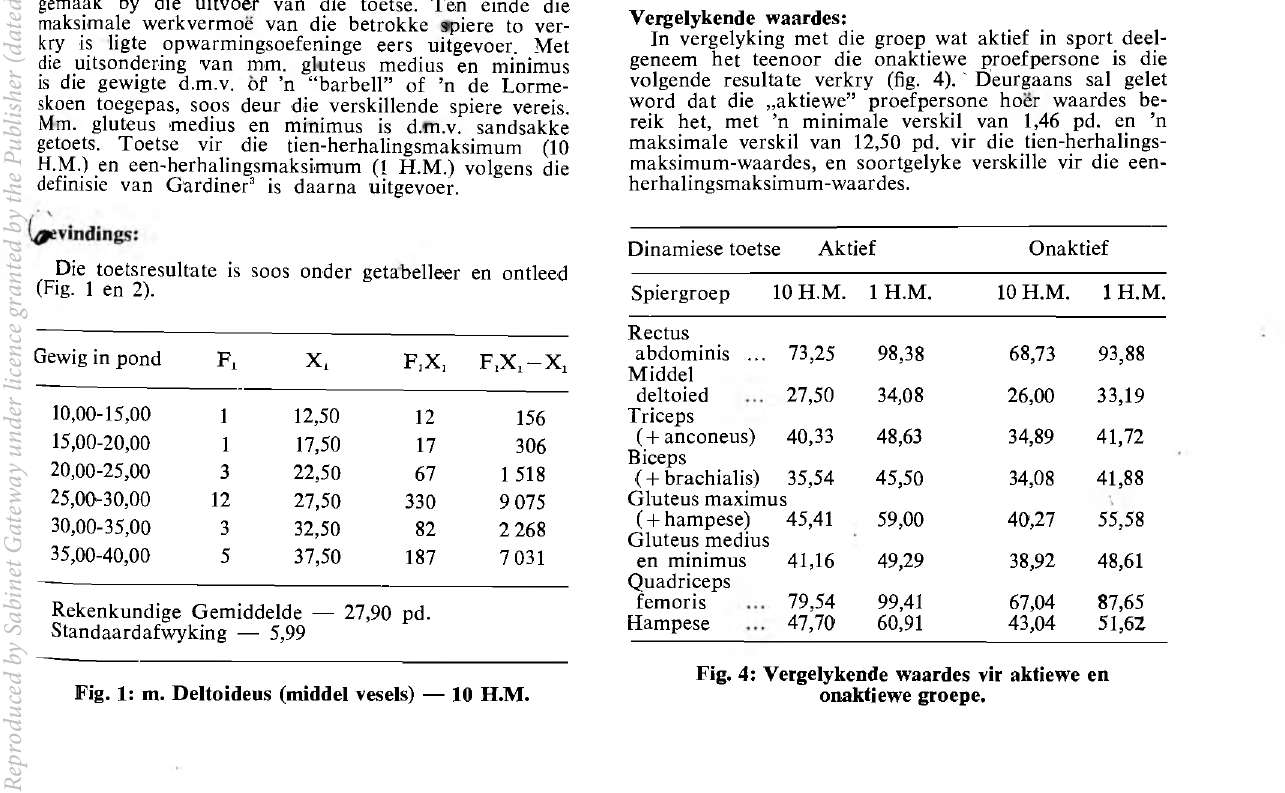
Fig. 3: Gemiddelde 10 H.M. en 1 H.M. waardes.